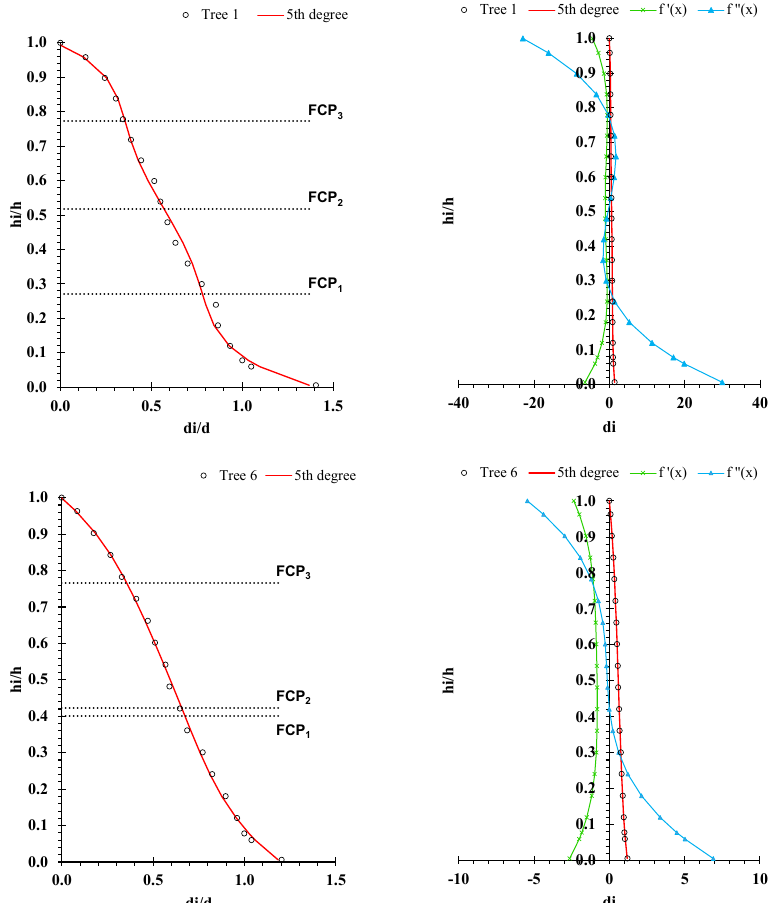
Figure 1. Medium profile derived from the 5th-degree function of Schöepfer [40] and form change points (FCPs) of the stems of Tectona grandis L.f., central-west region, Brazil. Legend: h i /h − ratio between height at position i (h i ) and height (h); di − diameter (cm) with bark at position i obtained by the function x and its derivatives f’(x) and f’’(x); di/d—ratio between diameter at position i (d i ) and diameter at breast height (d); f’(x) − first derivative of f(x); f”(x) − second derivative of f(x).